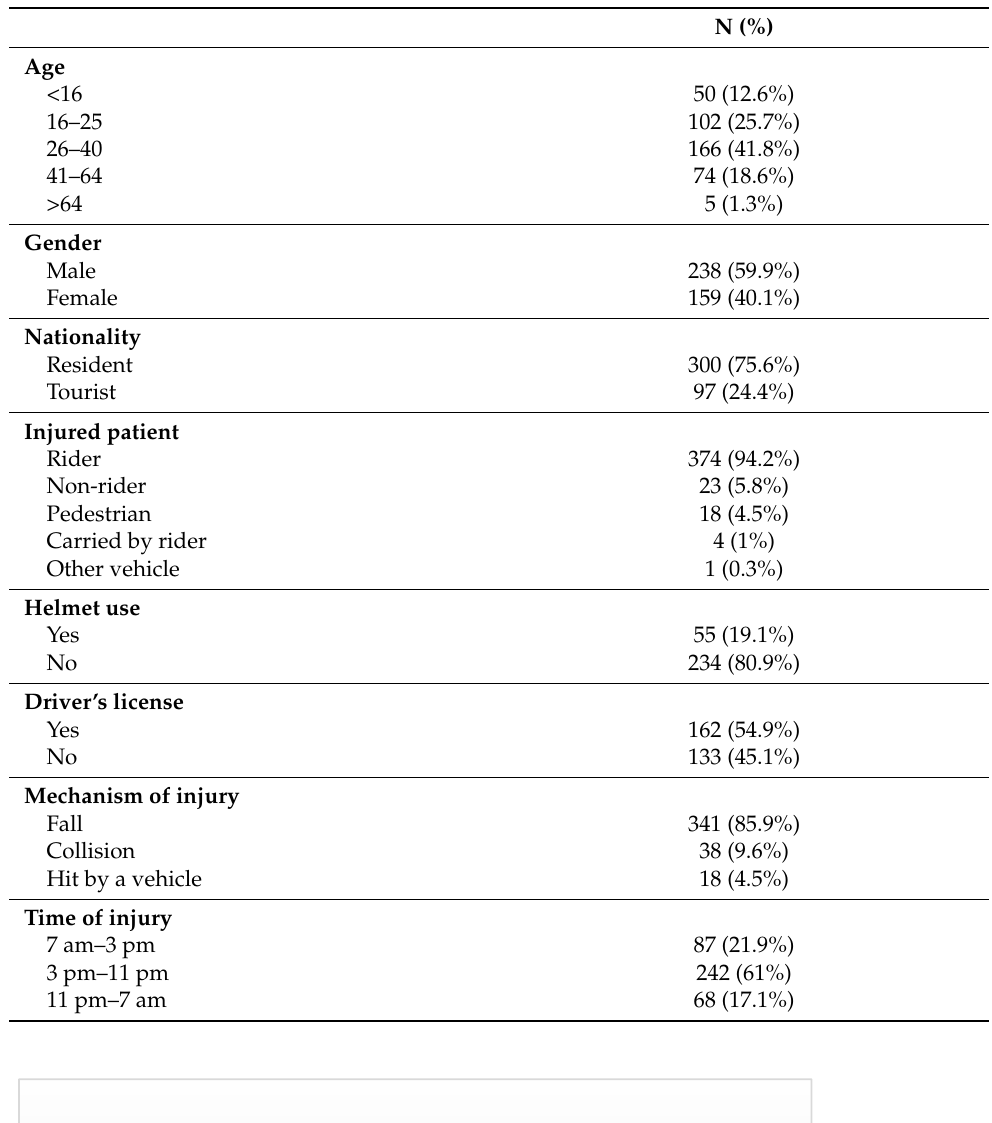
Table 1. Patient and accident characteristics associated with e-scooter-related injuries during a 1-year study period.